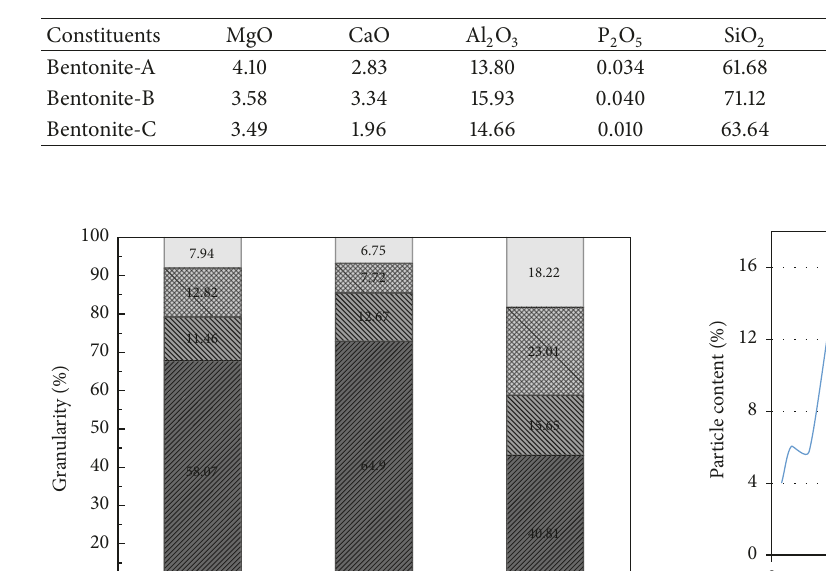
Table 2: Chemical analysis of the bentonites (%).